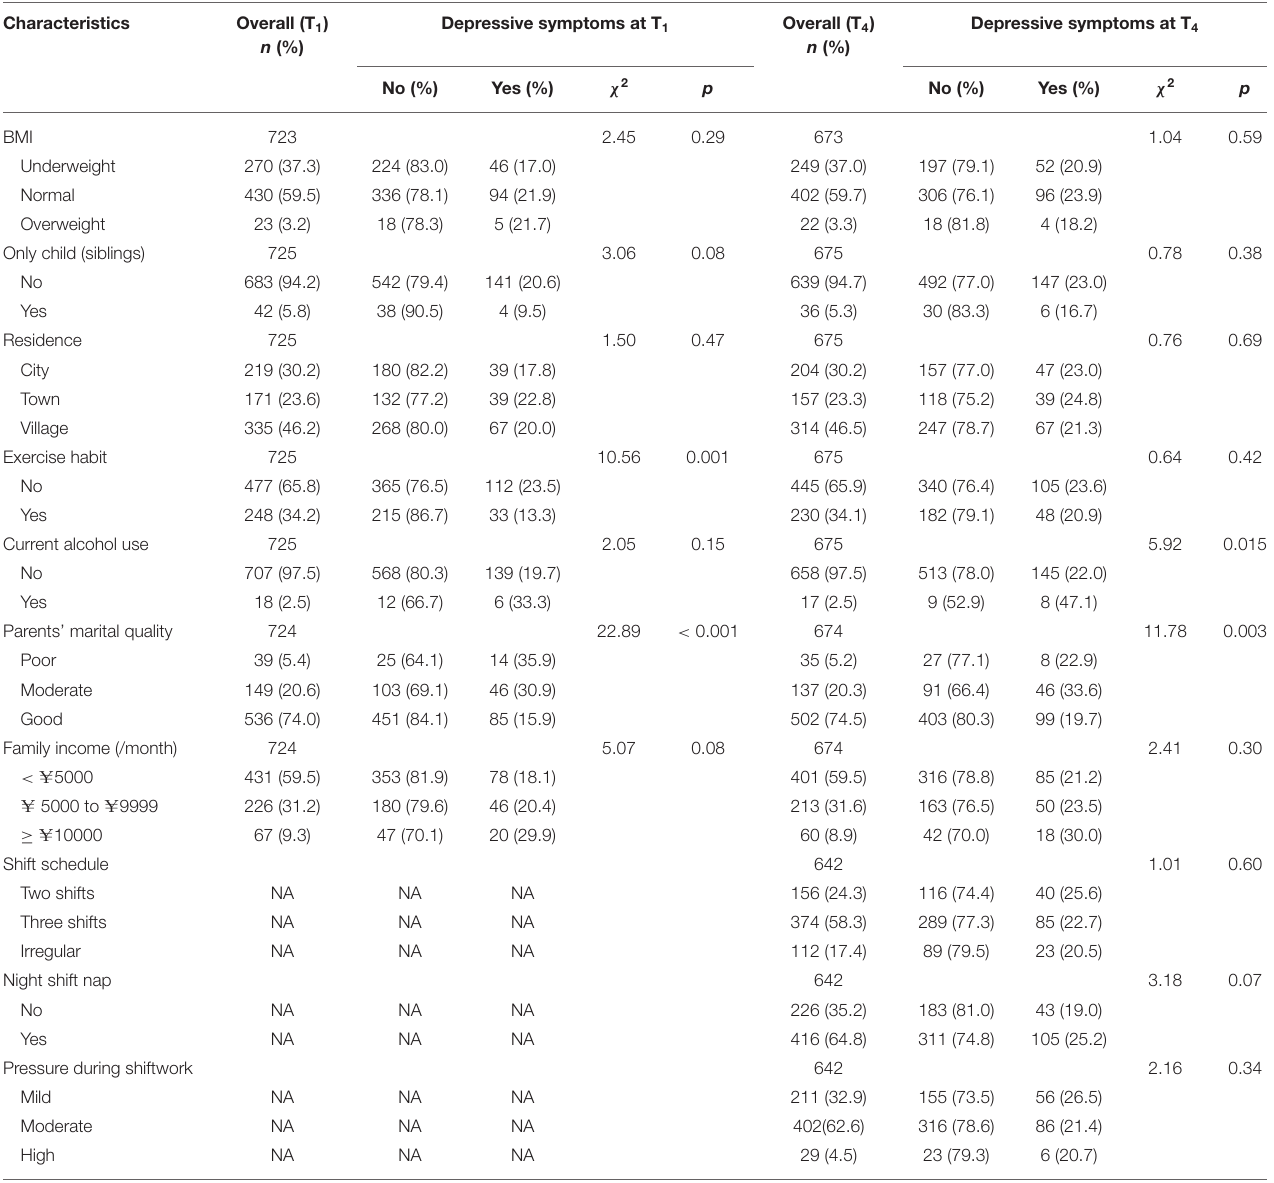
TABLE 1 | Characteristics of depressive symptoms at T 1 and T 4